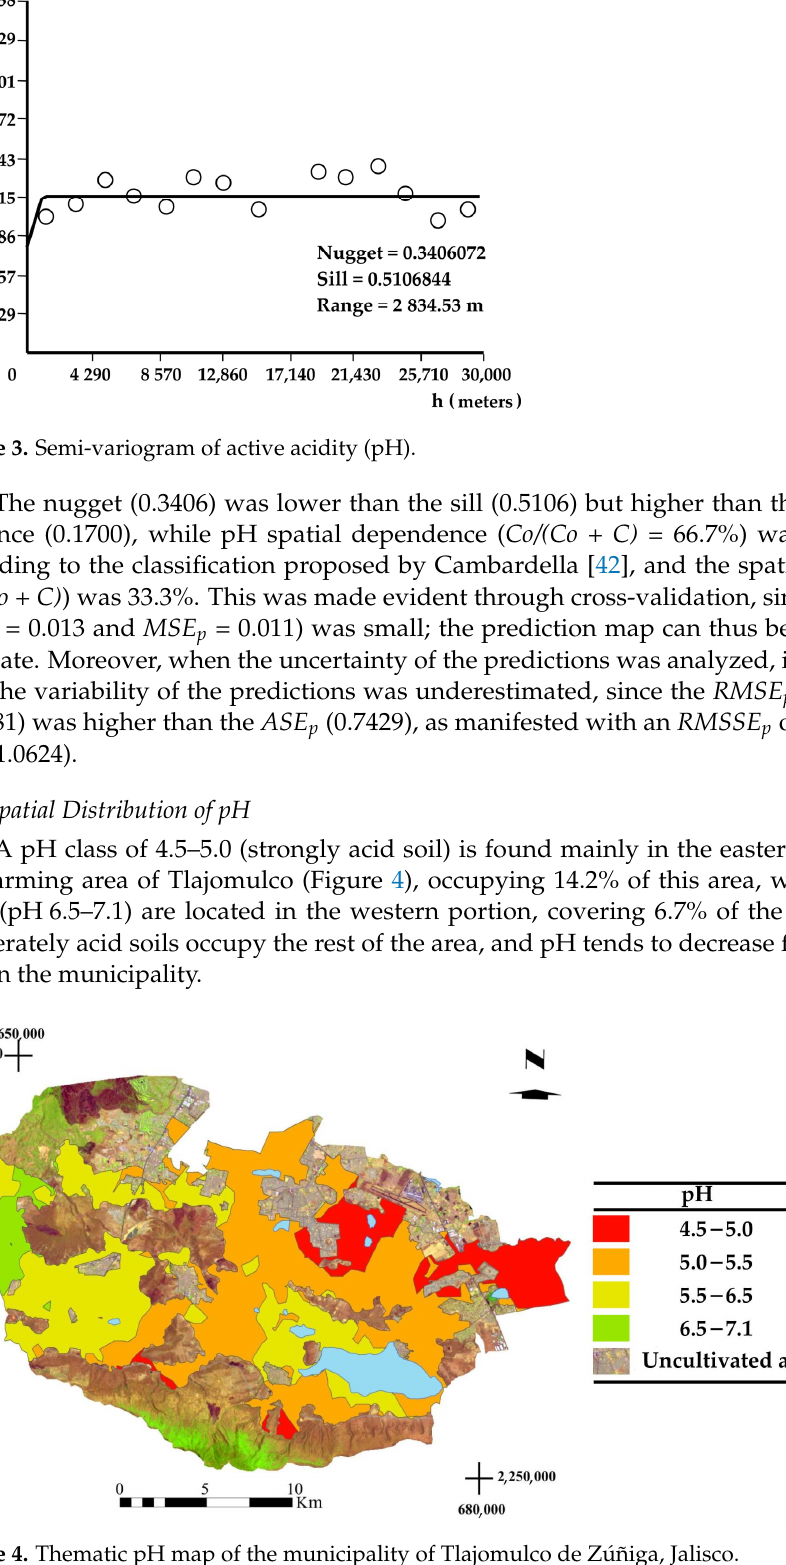
Figure 4. Thematic pH map of the municipality of Tlajomulco de Zúñiga, Jalisco.